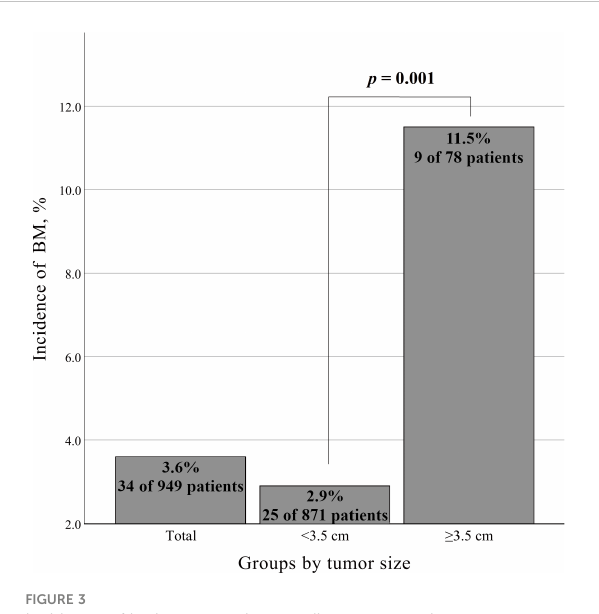
FIGURE 2 Charts for different cutoff points with corresponding p values for difference in the incidence of brain metastasis. The dotted line represents a Bonferroni-adjusted signi fi cance level of 0.007. BM, brain metastasis.